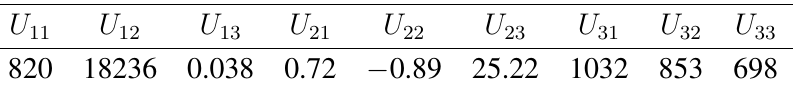
Table 5. Features of a test tobacco leaf.